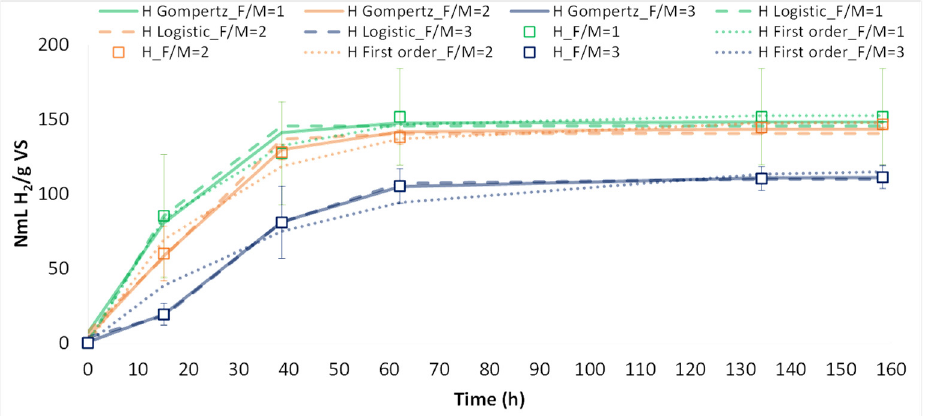
Figure 5. Cumulative H 2 production, modified Gompertz model, the first-order, and the modified Logistic model at different substrate/inoculum (S/I) ratios from the dark fermentation of the winter/autumn fruit and vegetable waste mixture.